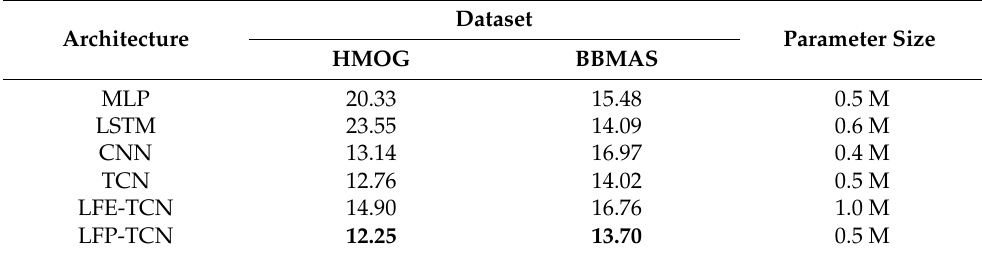
Table 3. Averaged EERs ( % ) for different architectures.